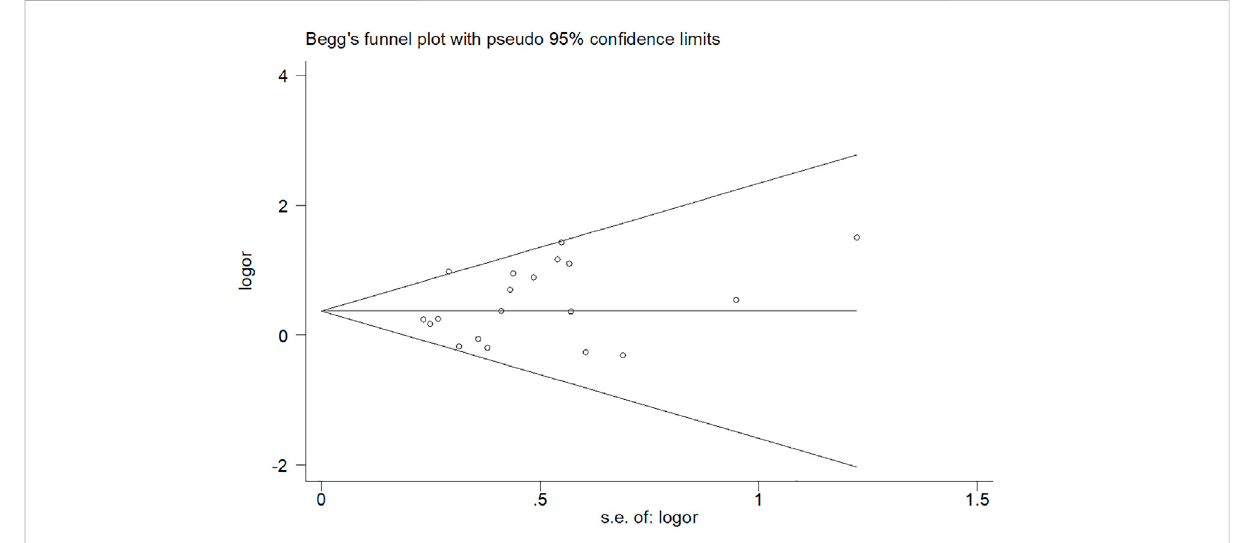
FIGURE 3 Begg ’ s funnel plot of the relationship between MTHFR gene (C677T) polymorphism and intracerebral hemorrhage